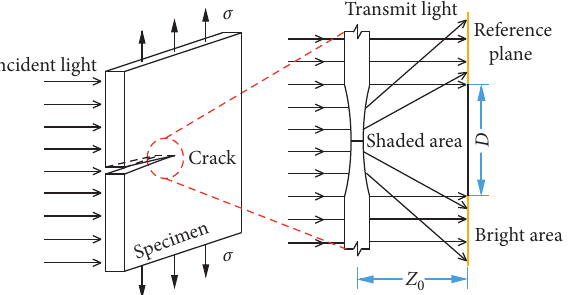
Figure 1: Imaging diagram of the caustics.